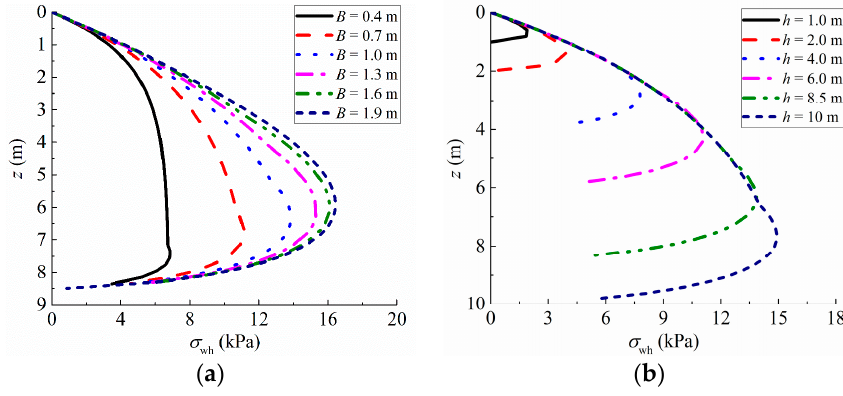
Figure 14. Influence of ( a ) B and ( b ) h on σ wh .